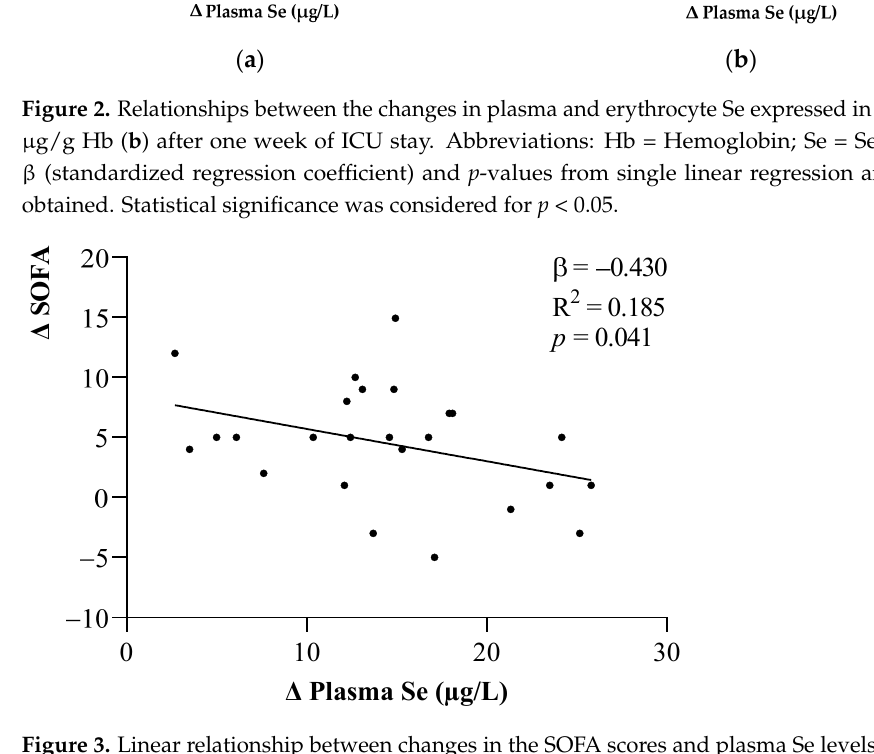
Figure 3. Linear relationship between changes in the SOFA scores and plasma Se levels. The β (standardized regression coefficient) and p -values from multiple linear regression analyses were obtained. Statistical significance was considered for p < 0.05. Abbreviations: Se = Selenium; SOFA = Sequential Organ Failure Assessment.